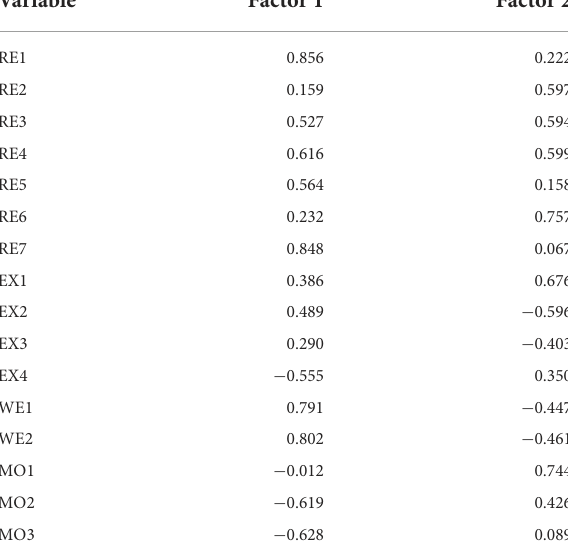
TABLE 6 Factor loadings